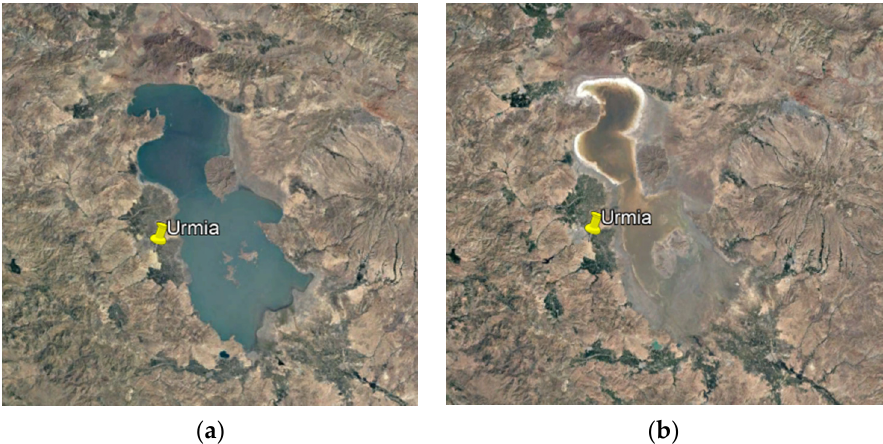
Figure 2. MODIS True-color satellite images of different water coverage in Lake Urmia in the De-